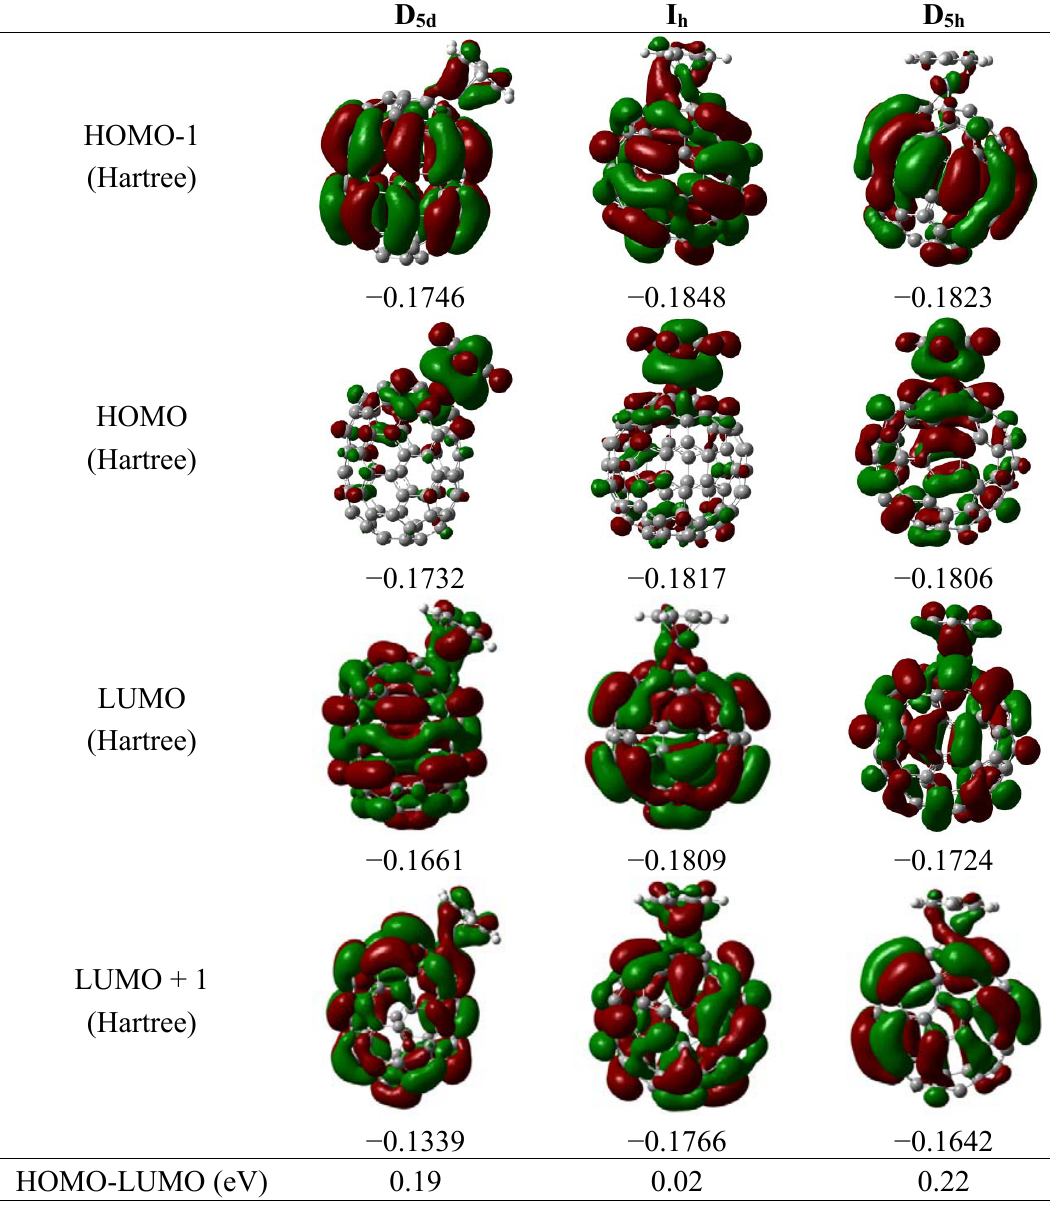
Figure 3. Frontier molecular orbital of the isomers D